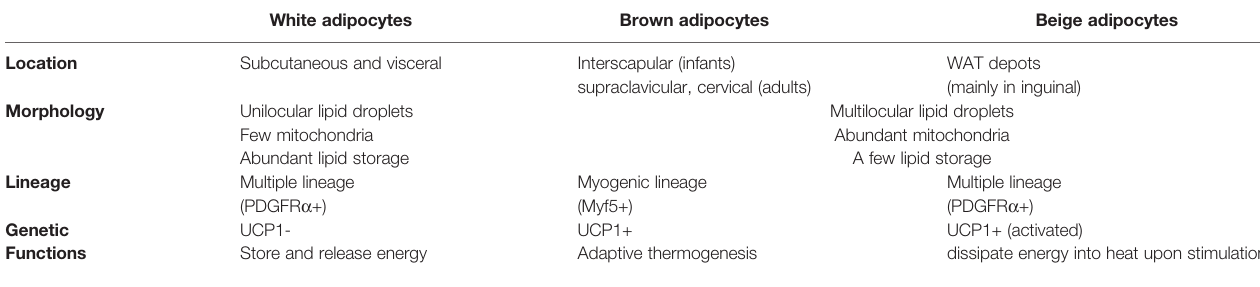
TABLE 1 | Characteristics of different kinds of